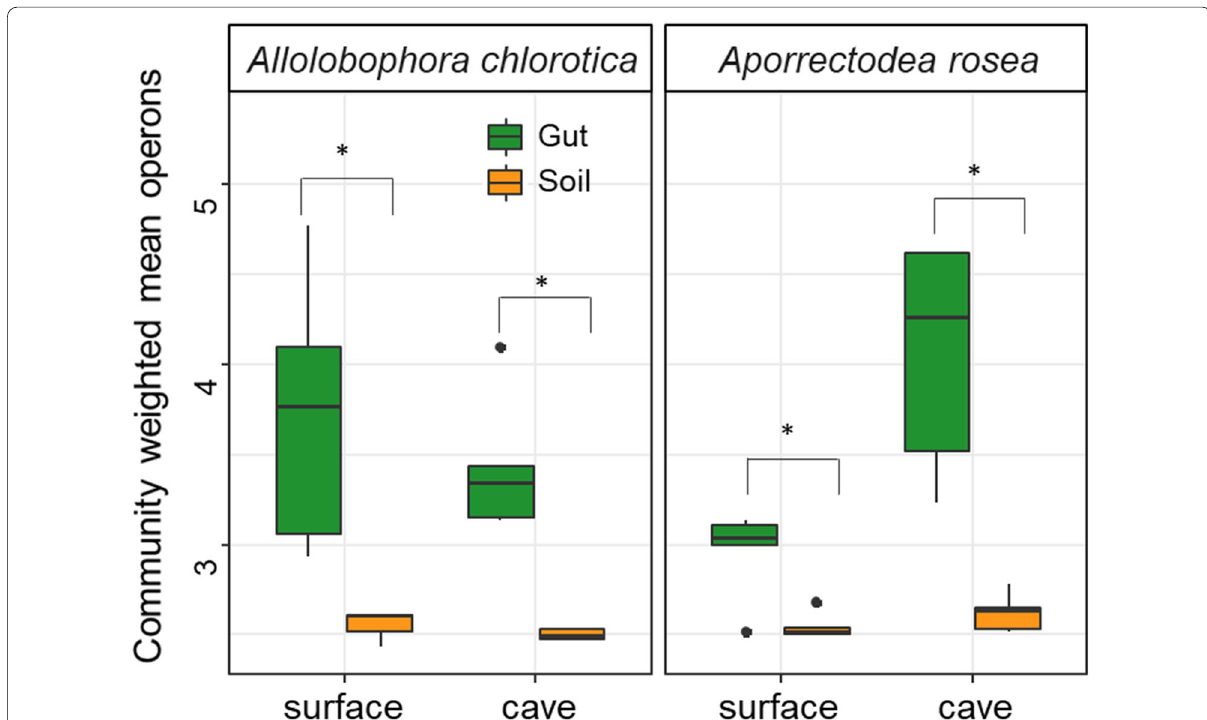
Fig. 4 Community weighted mean (CWM) of 16S rRNA gene copy numbers in the soil and gut of earthworms present in caves and the surface. Copy numbers were estimated using PICRUSt and weighted values were obtained by multiplying copy numbers by the relative abundance for each operational taxonomic unit and taking the sum of these values for each community